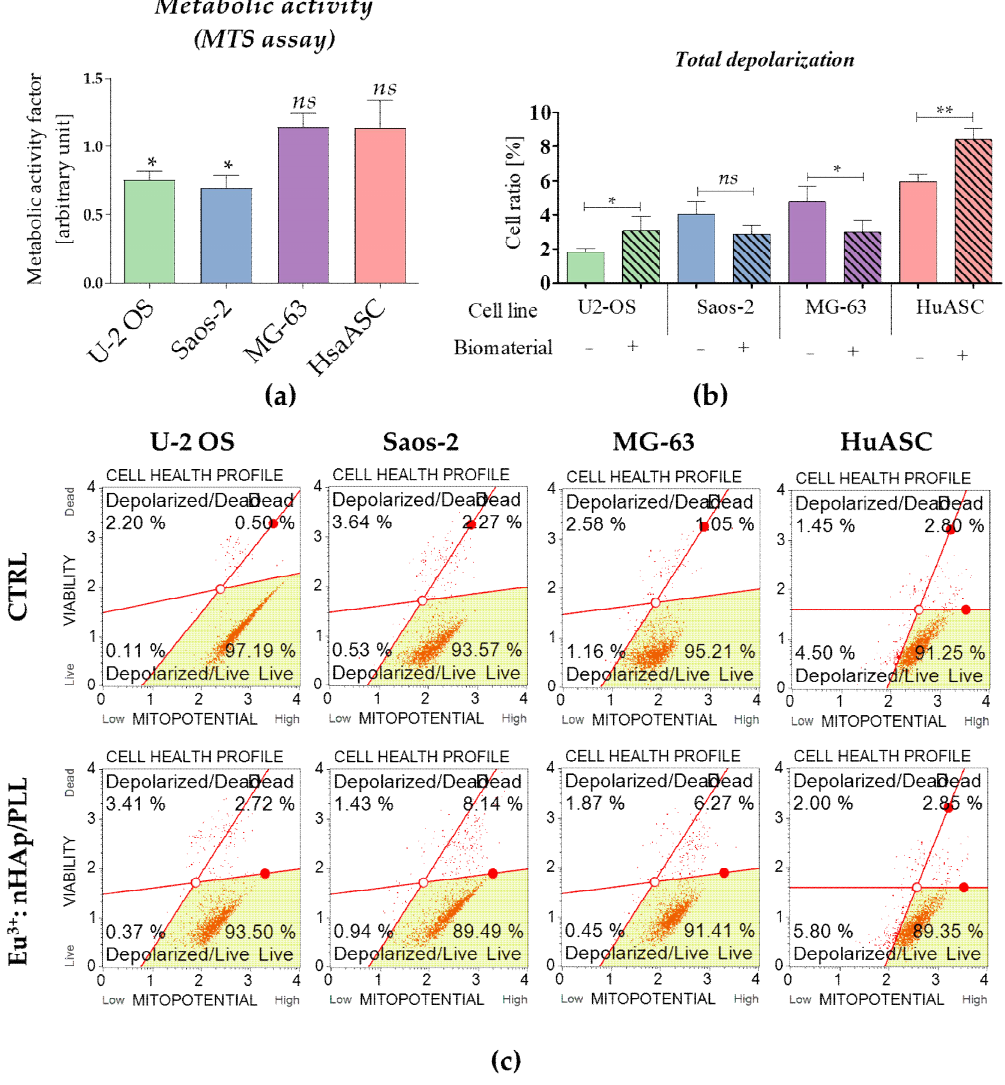
Figure 4. Analysis of cells metabolism in tested culture conditions. ( a ) Metabolic activity was determined using MTS assay. The arbitrary unit reflecting metabolic activity factor was determined for experimental cultures, in reference to the control cultures (considered as 1 = 100% of metabolic activity). ( b ) Mitochondria membrane potential was determined using cytometric-based method. Statistical analysis was performed for the cells with depolarized mitochondrial membrane – total depolarized (live and dead) ( c ) The representative images show distribution of cells based on mitopotential. Cells were separated into four populations: live ( Live —bottom right corner), with depolarized mitochondrial membrane and live ( Depolarized / Live —bottom left corner), with depolarized mitochondrial membrane and dead ( Depolarized / Dead – upper left corner) and dead ( Dead —upper right corner). The statistically significant significant differences were marked with an asterisk (***p < 0.001; **p < 0.01, *p < 0.05). Non-significant results of comparison are marked as ns .